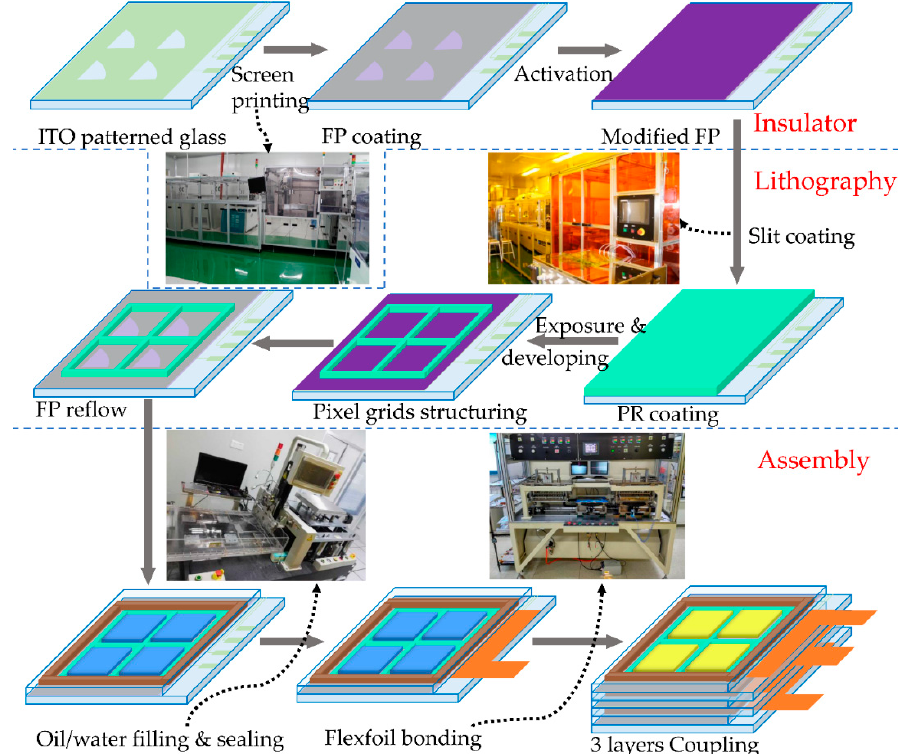
Figure 3. Schematic of scalable and efficient fabrication steps for a three-layer colorful segmented electrowetting display, including photos of some equipment.